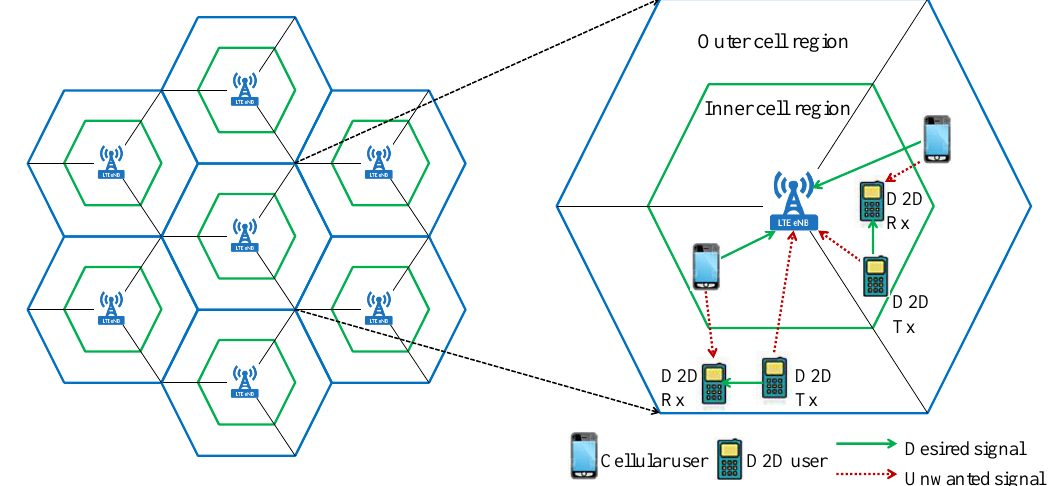
Figure 1. Device-to-device (D2D) communication network model.